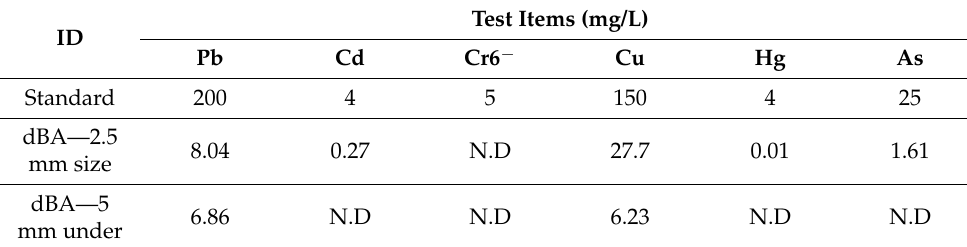
Table 7. Heavy metal content analysis type—II.